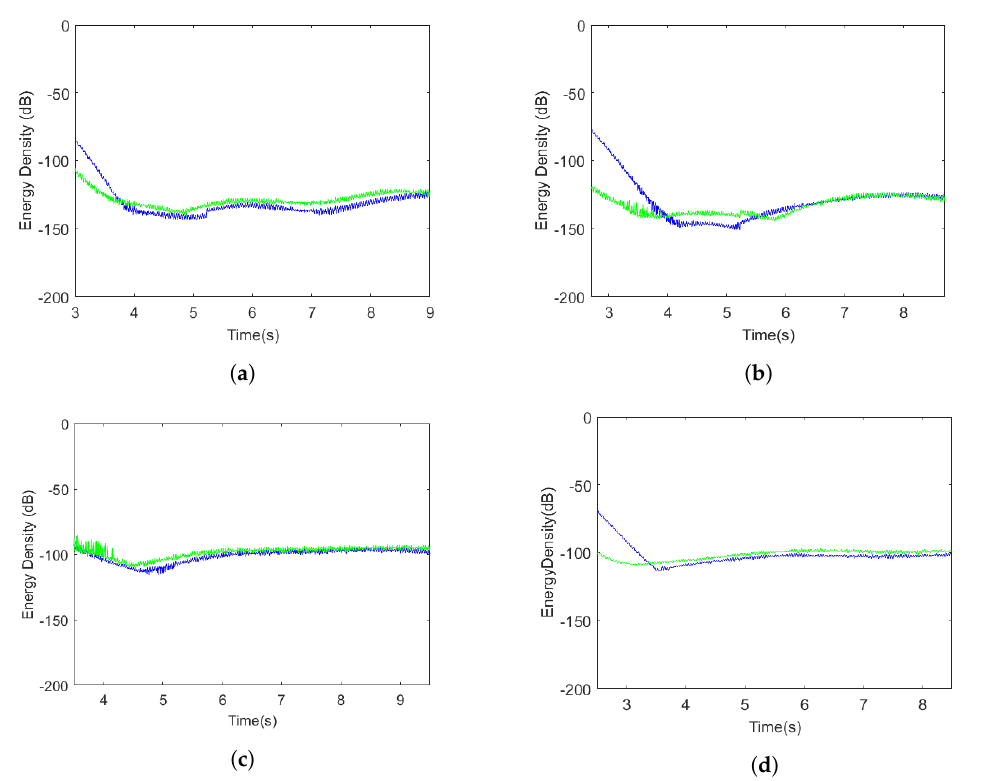
Figure 6. Fault severity quantification curves from the time-frequency distribution of Figure 5 for the following: ( a ) Healthy motor under low load; ( b ) Healthy motor under high load; ( c ) Motor with one broken rotor bar under low load; ( d ) Motor with one broken rotor bar under high